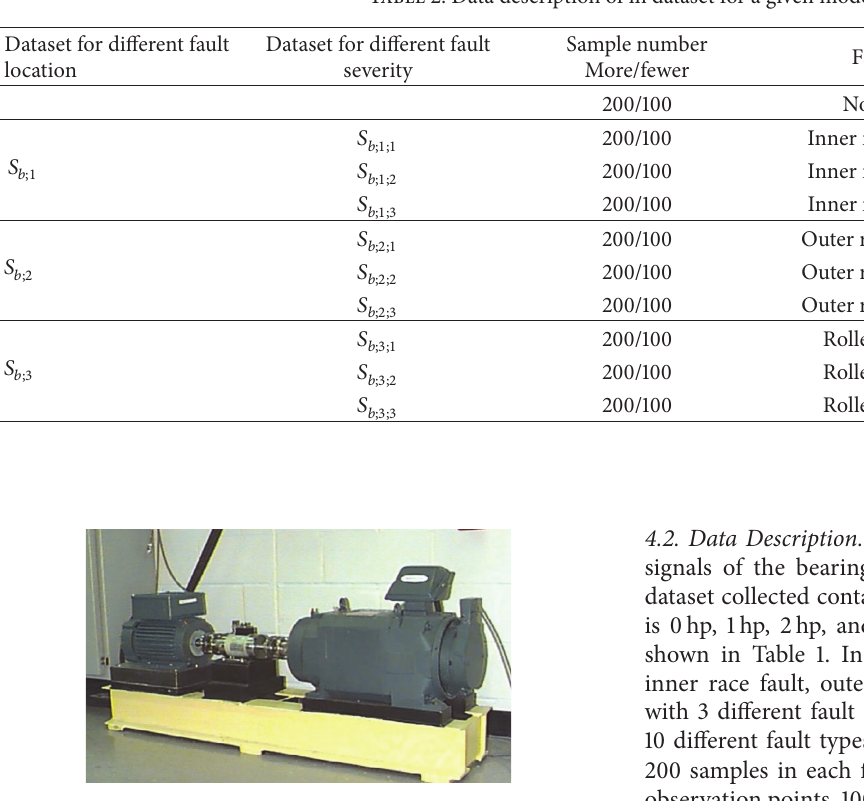
Table 2: Data description of in dataset for a given mode.